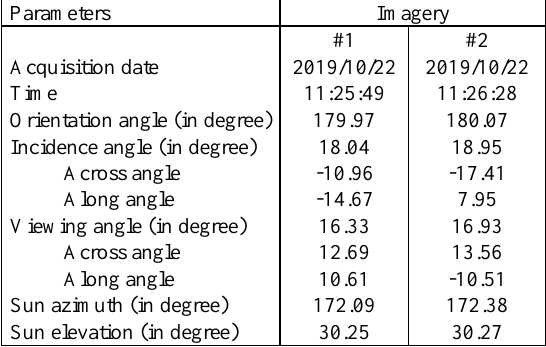
Table 1. Pleiades-1A specifications related to the stereo- acquisition over the study site